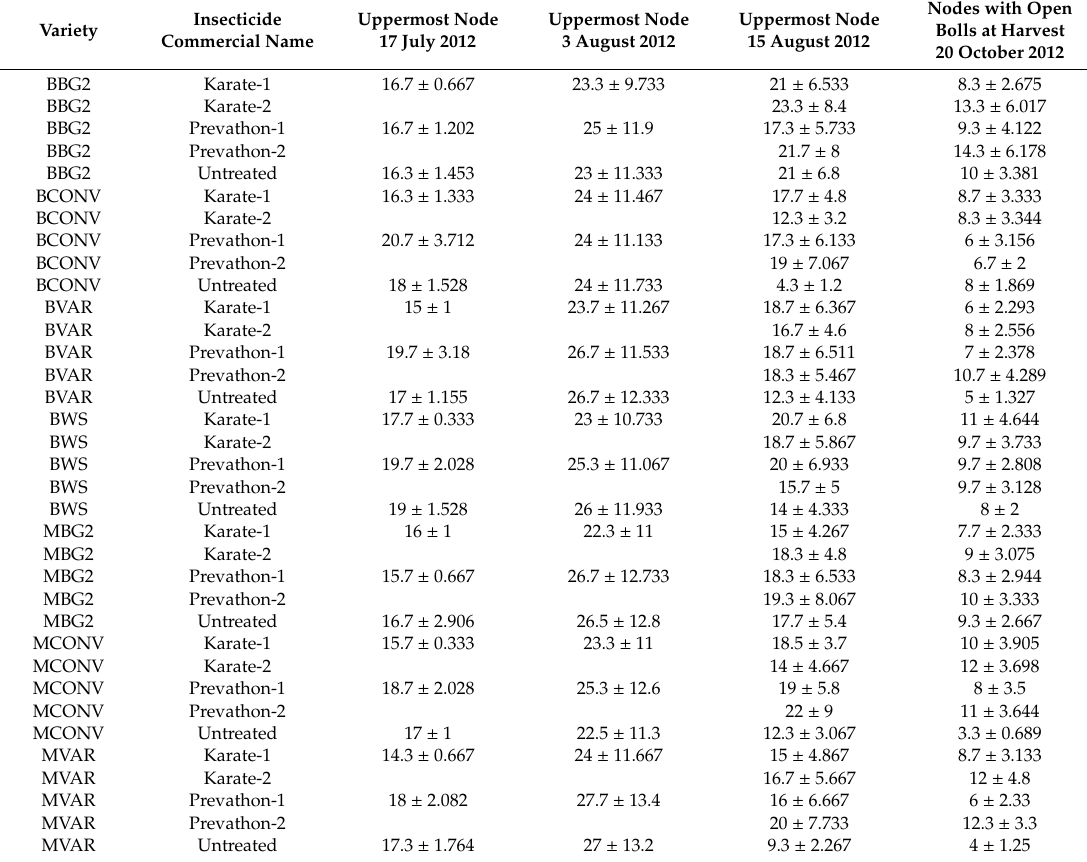
Table 7. Mean ± SEM uppermost node bearing fruit per plant on three within-season sample dates and total nodes with open bolls at harvest in